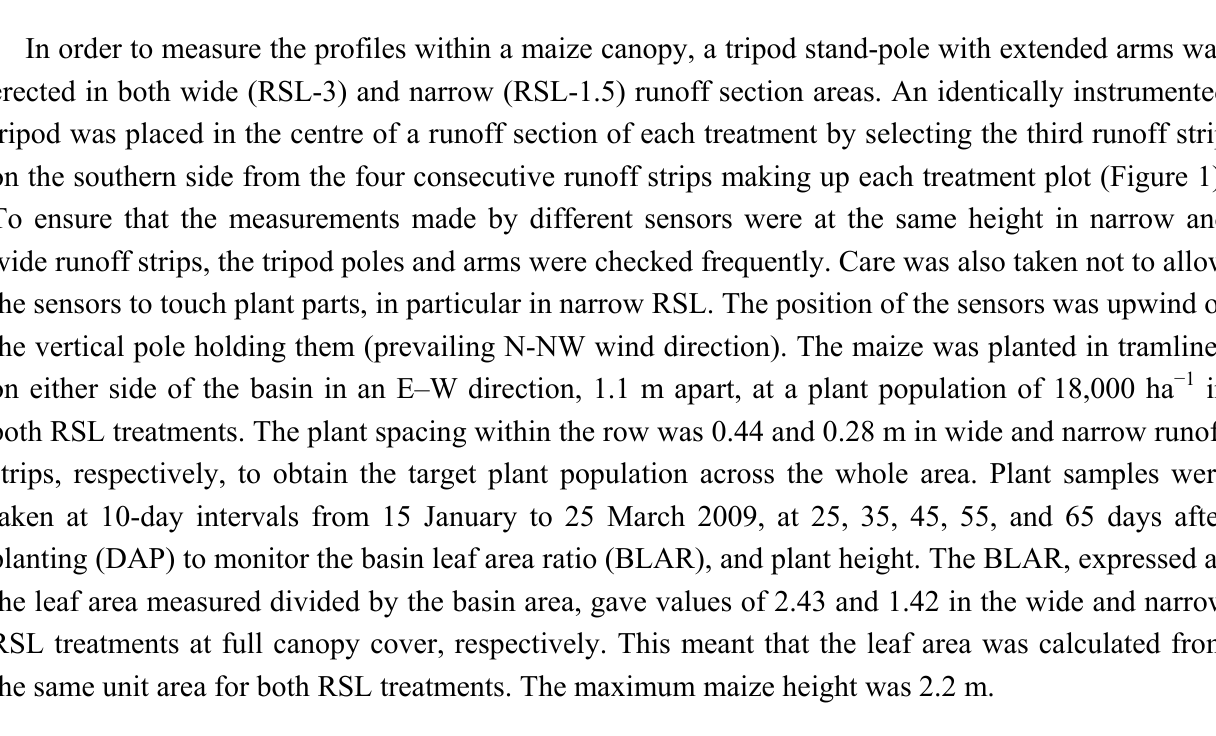
) at heights above i